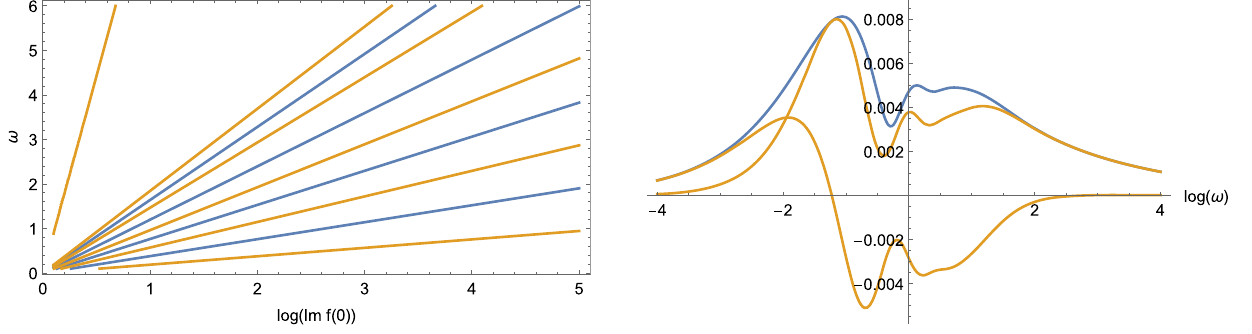
Fig. 4 A two-dimensional plot of the zeroes of the real and imaginary parts of G (ω, Im f ( 0 )) in five dimensions